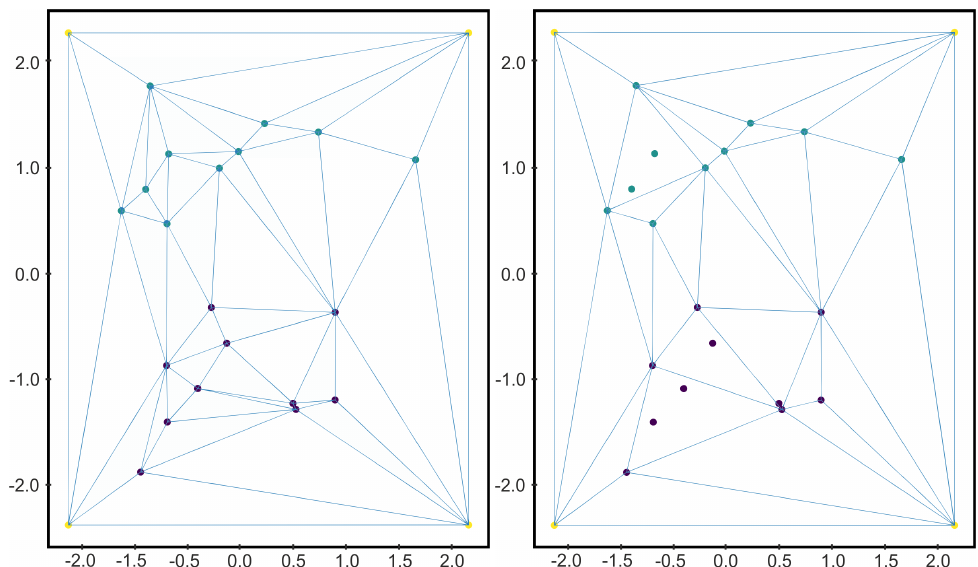
Figure 2. On the left, the Delaunay triangulation of the labeled data set D given in Figure 1 together with the vertices of the square polytope surrounding D . On the right, the Delaunay triangulation of a subset of D obtained as described in Algoritm 1. As we can see, the triangles whose vertices belonged all to the same class